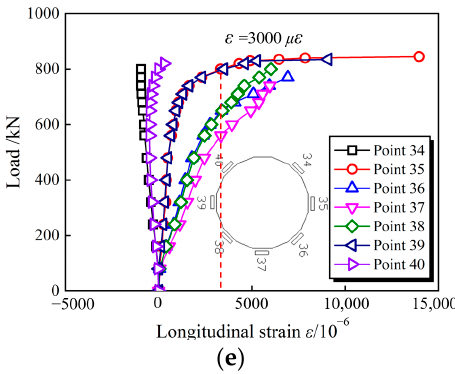
Figure 8. Failure modes of CFHST beams at different stages. ( a ) C240 ‐ 1; ( b ) C280 ‐ 1; ( c ) C320 ‐ 1; ( d ) C360 ‐ 1; ( e ) C400 ‐ 1.